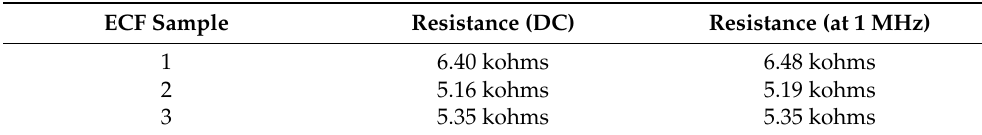
Table 1. Resistance values obtained from three polyester ECFs, each of 2.5 cm length using a voltage- ohmmeter (center column) and the impedance analyzer (right